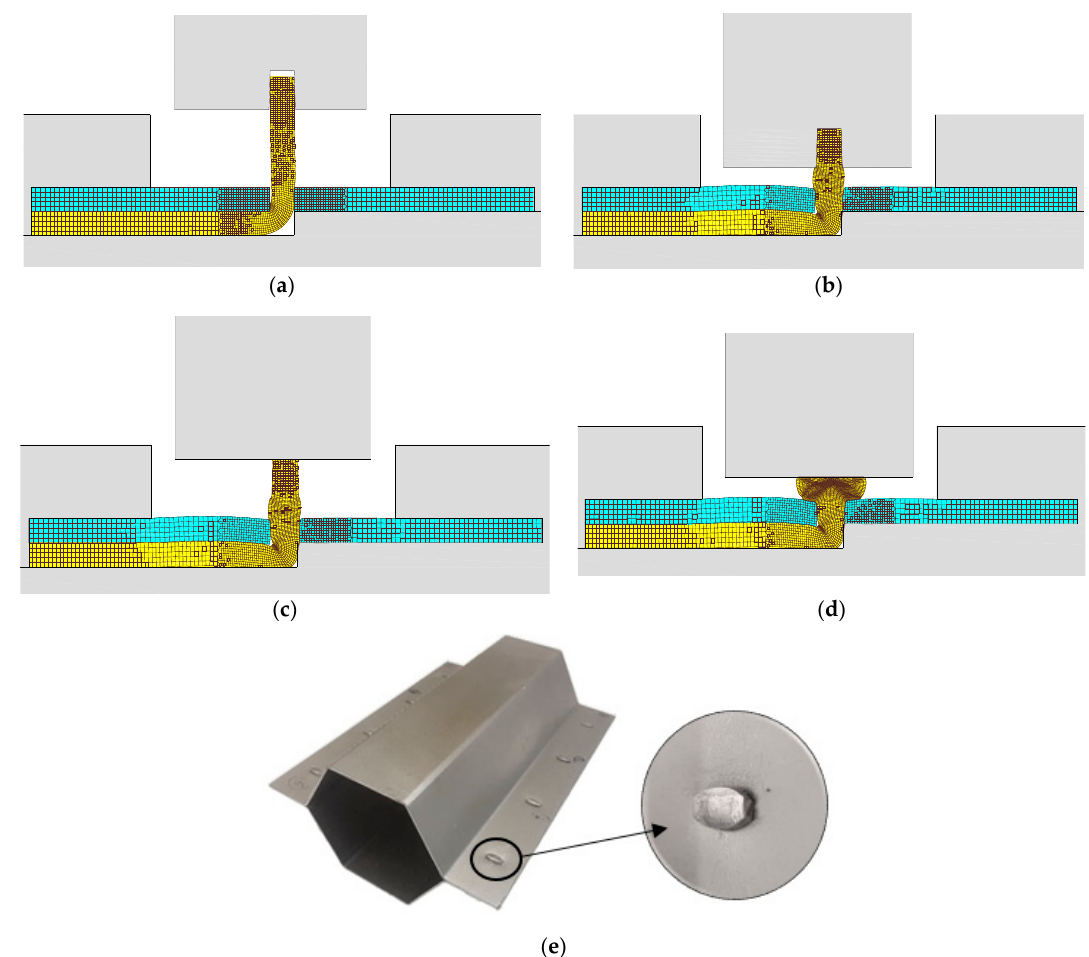
Figure 6. Fabrication of the crash boxes by sheet-bulk compression with “mortise-and-tenon” joints ( h = 4.5 mm): ( a ) finite element mesh at the beginning of the first stage; ( b ) computed finite element mesh at the end of the first stage; ( c ) computed finite element mesh at the beginning of the second stage; ( d ) computed finite element mesh at the end of the second stage; ( e ) crash box with a detail showing the flat-shaped surface head of a compressed tenon.